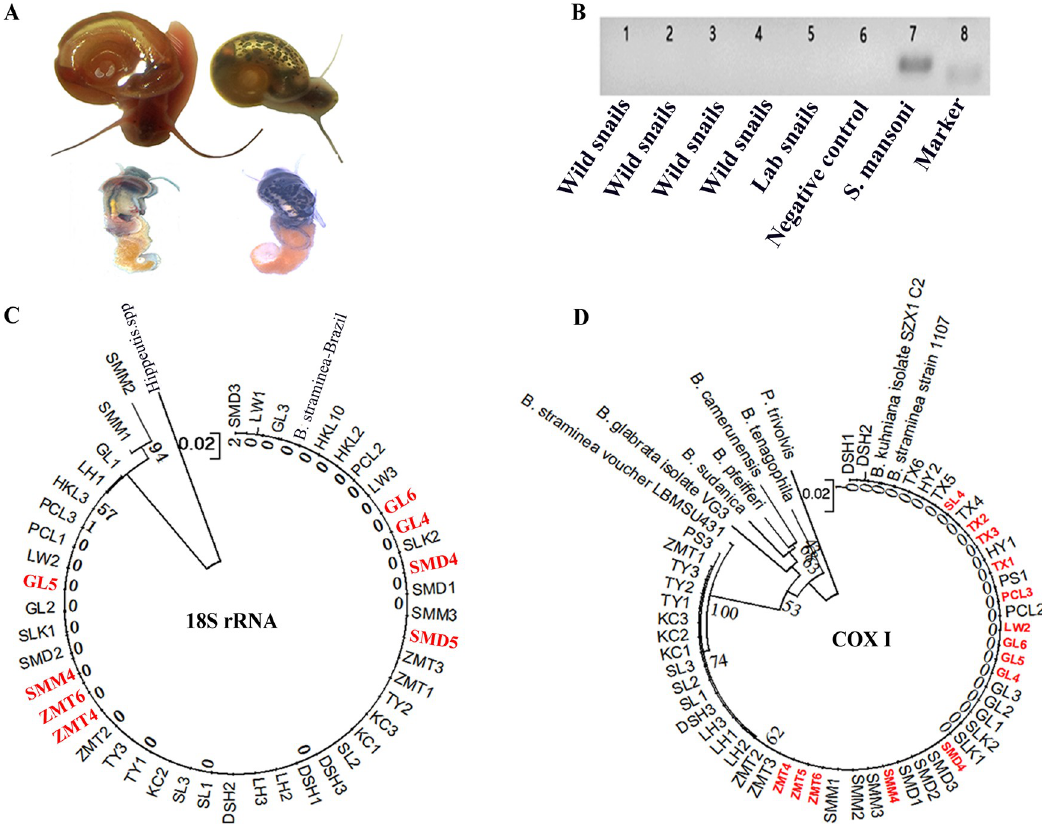
Fig 5. Morphological and phylogenetic features of B . straminea collected in fields and kept in laboratory. ( A ) Picture of B . straminea snails, upper: black colored snail; down: red colored snail. ( B ) Example of PCR amplifying S . mansoni specific 18S rRNA sequence extracted from field captured B . straminea (Lane 1–4), laboratorial cultured B . straminea (Lane 5), negative control (Lane 6) and adult worms of S . mansoni (Lane 7). Lane 8: 210 bp marker. ( C ) Neighbour-joining tree constructed based on K2P+G model for 18S rRNA sequences of B . straminea samples collected from different sites in south China. ( D ) Neighbor-joining tree constructed based on K2P+G model for cox1 sequences of B . straminea samples collected from different sites in South China.